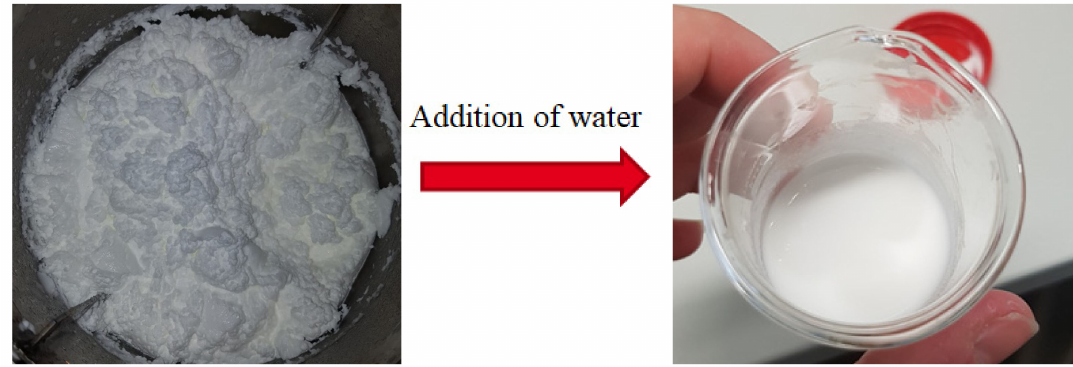
Figure 6. Successful redispersion of the product by adding